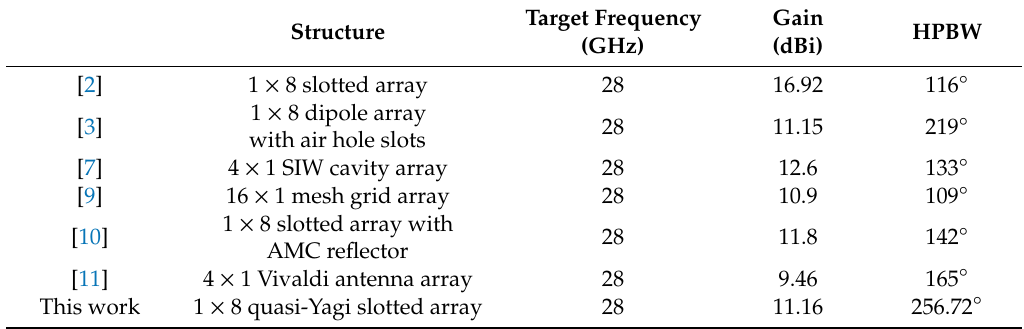
Table 1. Comparison with the state-of-the-art fan-beam antennas for mm-wave 5G